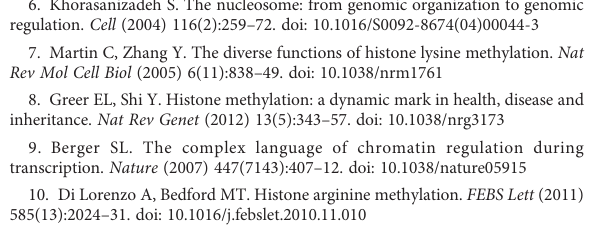
SUPPLEMENTARY TABLE 7 Abundance of each in fi ltrating immune cell among the three